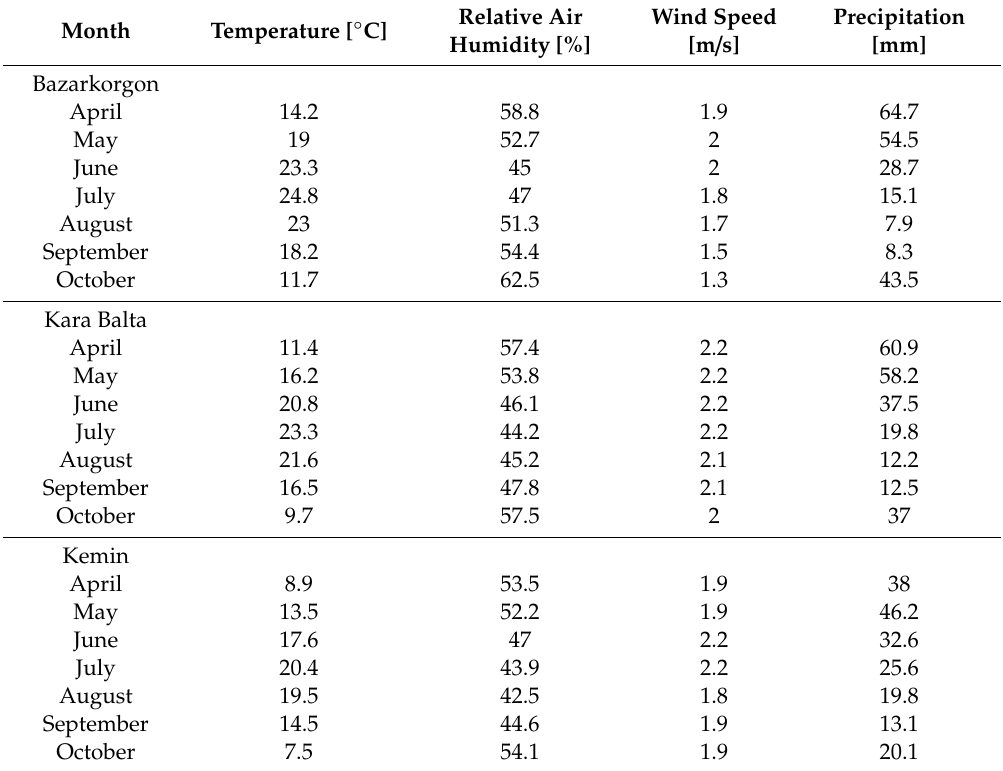
Table 1. Monthly average climate data from Bazarkorgon (16 km from Chek), Kara Balta (17 km from Temen Suu), and Kemin (5 km from Karasay Batyr) for the growing season, i.e., from April to October, 112 years observation (http: //